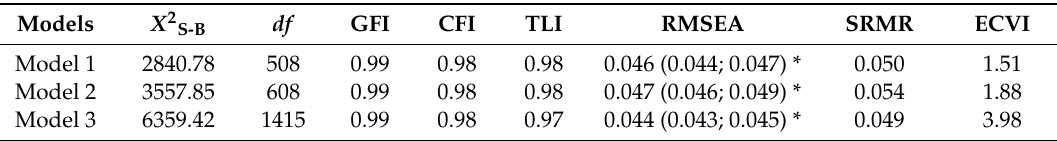
Table 2. Models fit